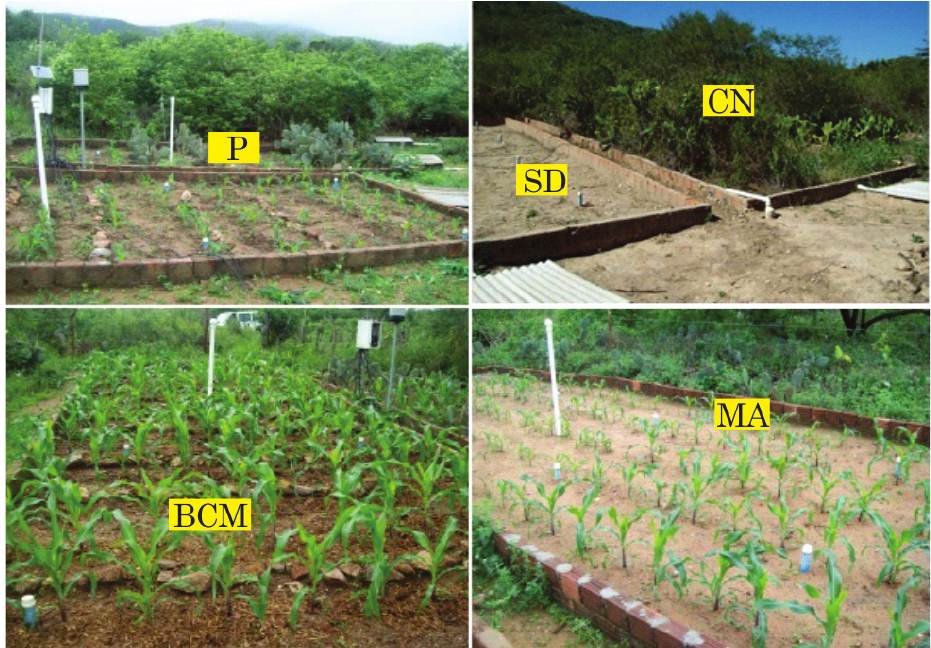
Figura 1. Fotos da área experimental tomadas aos 20 dias após o plantio do milho, apresentando os tratamentos utilizados nas parcelas experimentais. P: cultivo do milho com cordão vegetativo com palma forrageira; SD: solo descoberto; CN: cobertura natural; BCM: cultivo do milho em nível com barramento em pedras associado com cobertura morta; e MA: cultivo do milho morro